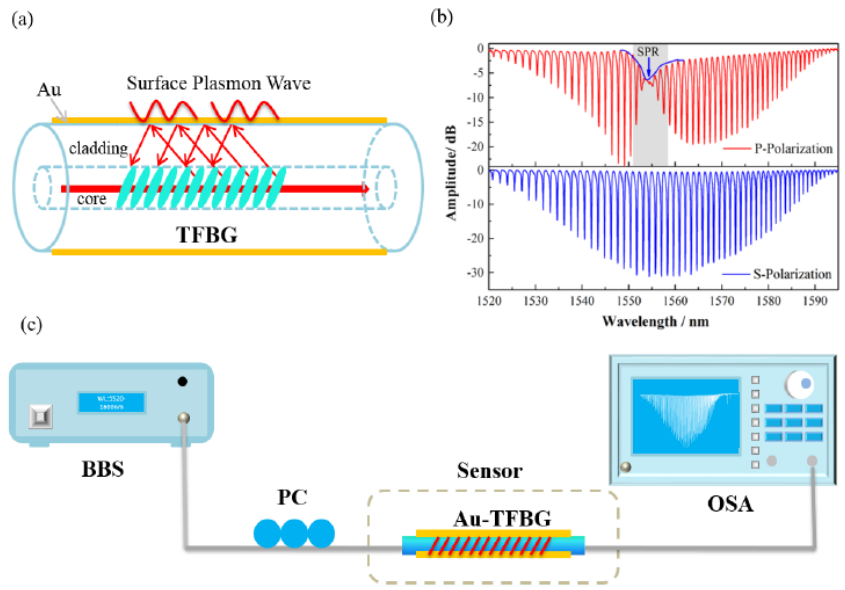
Figure 21. ( a ) Schematic demonstration of tilted fiber Bragg grating plasmonic biosensor in [50]. ( b ) Transmission spectra of the Bragg grating under P and S polarization, and ( c ) experimental setup for detection of bio-species using tilted fiber Bragg grating plasmonic biosensor. Figure reproduced under the terms of the CC-BY Creative Commons attribution 4.0 from Reference [50], Copyright 2017. The protein identification and immobilization process for boronic acid derivative and glycoprotein in their proposed biosensor is illustrated in Figure 22.